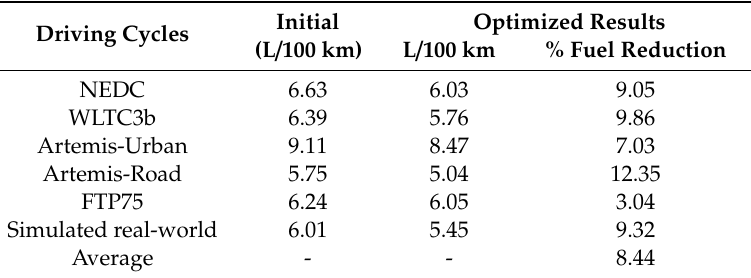
Figure 9. Optimized speed trajectory for the simulated real-world driving cycle ( β = 0.5). Table 1 represents the fuel reduction of the computed optimal eco-driving compared with the initial cycle, and the results show that an average reduction of eight percent in fuel consumption is achieved. One of the conclusions drawn is that the algorithm works more e ff ectively in high-speed compared to low-speed areas. Table 1. Optimization results for di ff erent driving